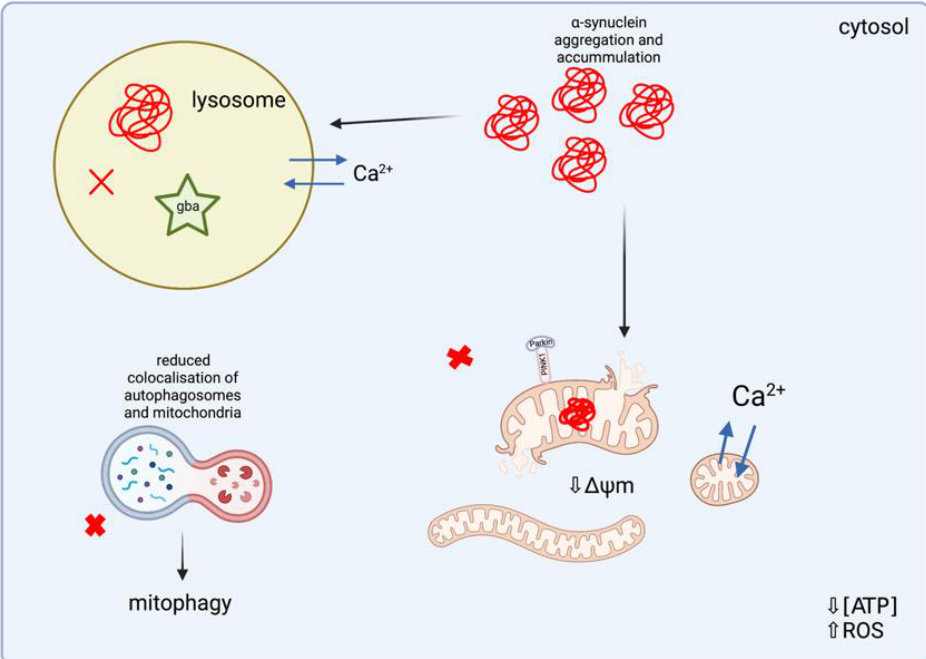
Figure 8. Molecular mechanisms leading to mitochondrial dysfunction in lysosomal storage disorders. Lysosomal dysfunction is associated with dysregulated autophagy/mitophagy pathways, leading to the accumulation of dysfunctional mitochondria within the cell. Mitochondria can be further damaged by the accumulation of aggregated α -synuclein causing altered mitochondrial morphology (small, rounded fragmented and elongated mitochondria). α -synuclein accumulation is also associated with dysfunctional mitochondrial bioenergetics, including reduced ∆Ψ m and ATP, increases in ROS levels, and altered Ca 2+ homeostasis, which are events leading to cell death. Impaired mitophagy also occurs as a consequence of impaired PINK1/parkin recruitment and/or function. Reduced recycling and the removal of mitochondria by mitophagy increases the number of damaged mitochondria within the cell due to reduced colocalisation of autophagosomes and mitochondria (created using biorender.com). ∆Ψ m—mitochondrial membrane potential; ATP—adenosine triphosphate; ROS—reactive oxygen species; PINK1—PTEN-induced kinase 1; gba — gluco- cerebrosidase.